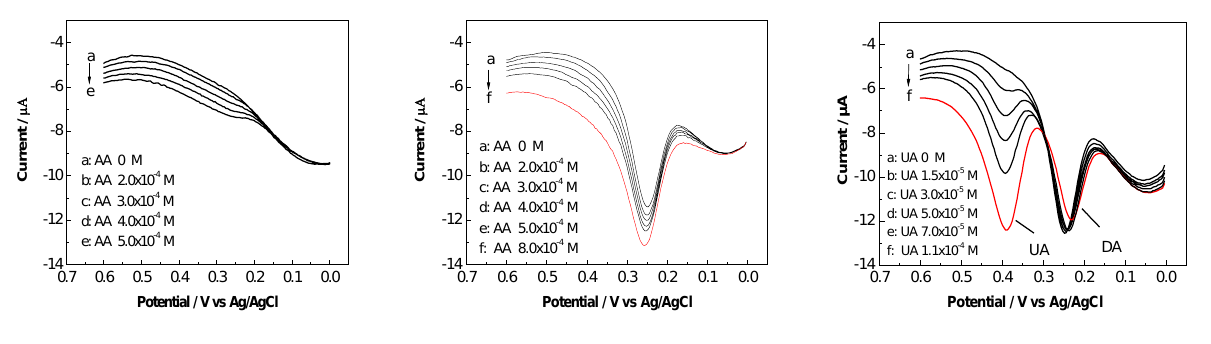
Figure 6. (A) Differential pulse voltammograms of AA at the modified electrode. (B) DA: 5.0 × 10 -7 M in the presence of different concentrations of AA. (C) Differential pulse voltammograms of 5.0 × 10 -7 M DA in the presence of different concentrations of UA. The experimental parameters are similar to Figure 1(A).